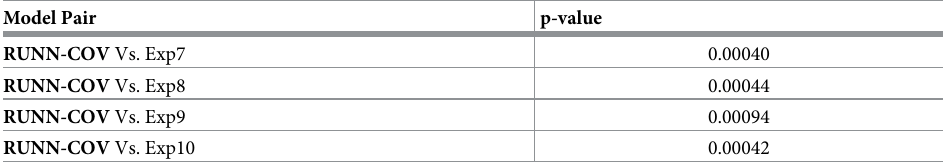
Table 6. Paired sample t-test. (significance level of